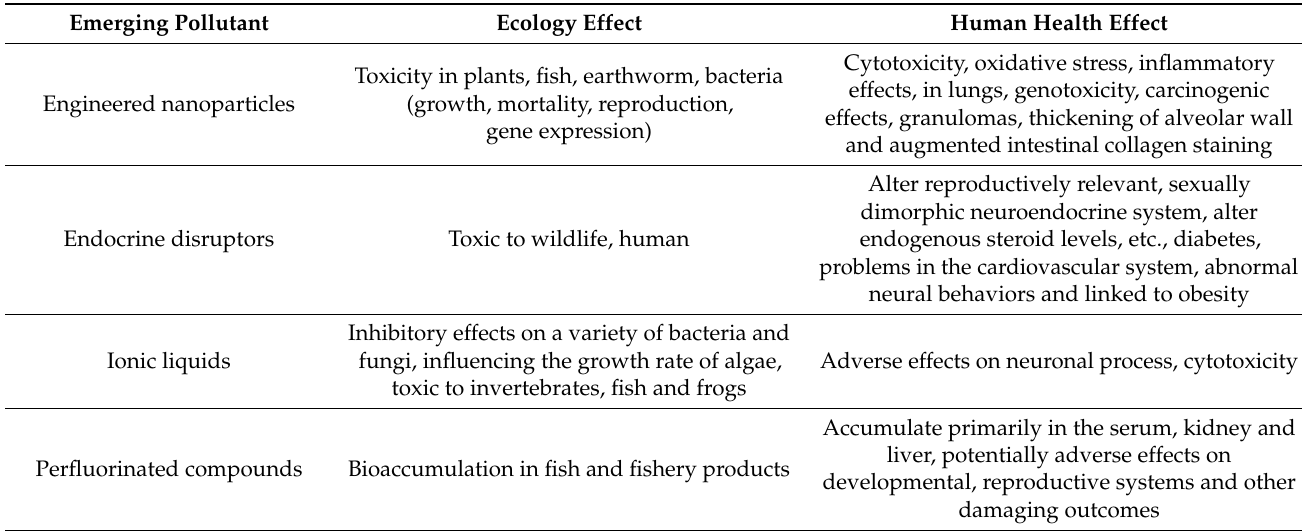
Table 3. The toxic effects of typical EPs in the environment [62]